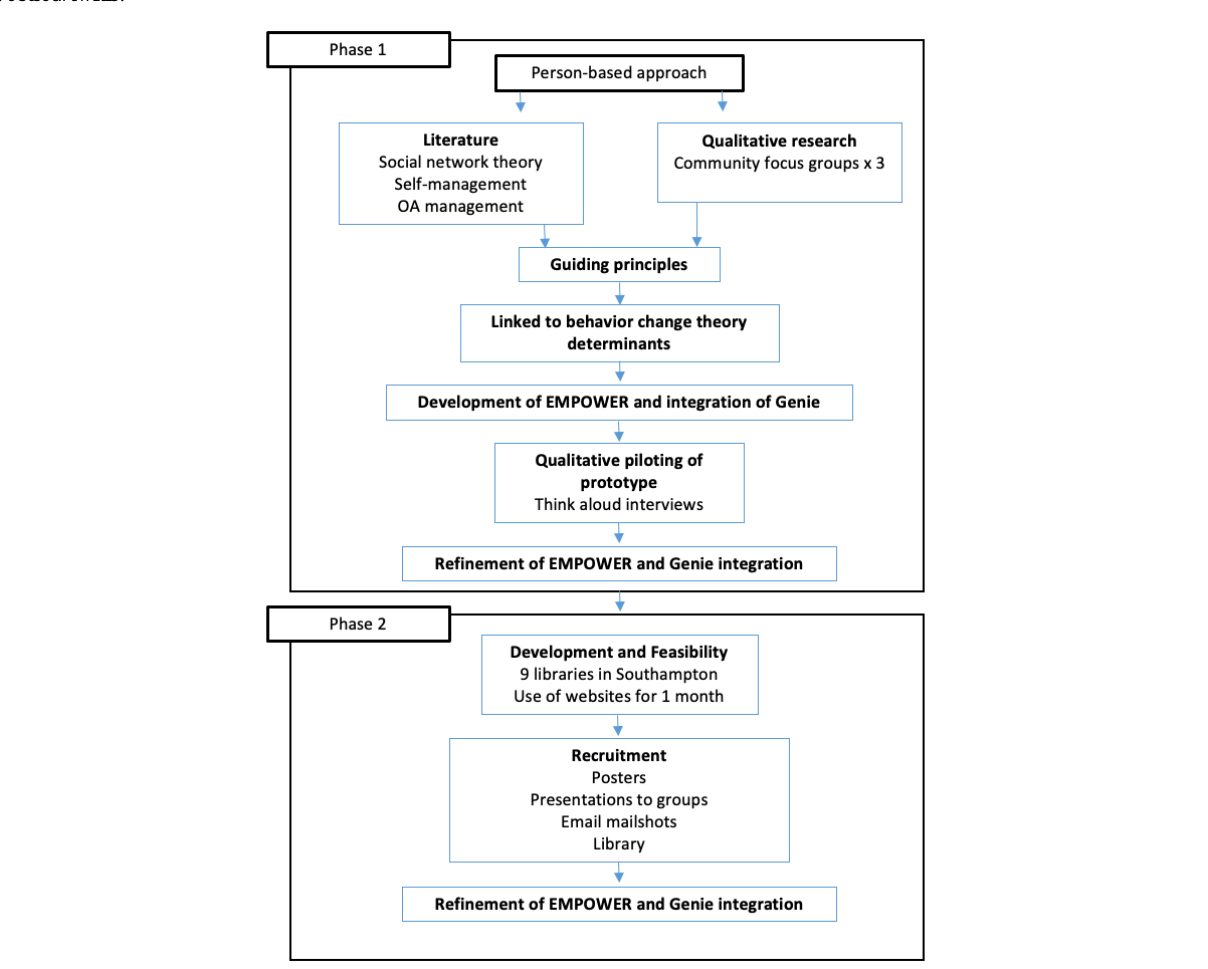
Figure 1. The person-based approach used for the design and development of the web-based intervention in phase 1 and small-scale evaluation using LifeGuide software. EMPOWER: Managing joint Pain On the Web and through Resources; Genie: Generating Engagement in Network Involvement; OA: